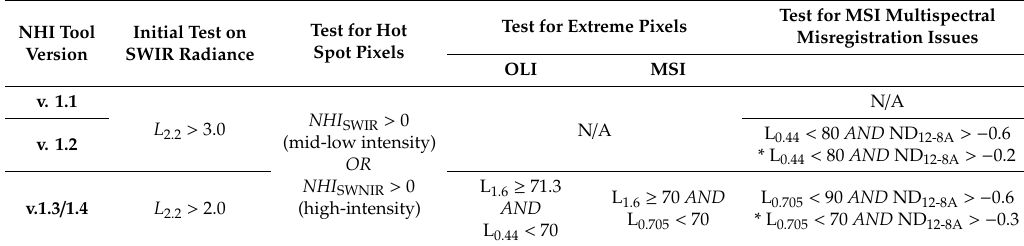
Table 1. Description of NHI tool versions. The test for extreme pixels takes into account the nominal saturation radiances of Short-Wave Infrared (SWIR) channel at 1.6 µ m wavelength (e.g., 71.3 W / m 2 sr µ m; for the Operational Land Imager (OLI)) (see [48,49]); (* tests applied only to pixels flagged by the index in Equation (2)). ND12-8A is a normalized index, using bands 12 and 8A of the Multispectral Instrument (MSI)